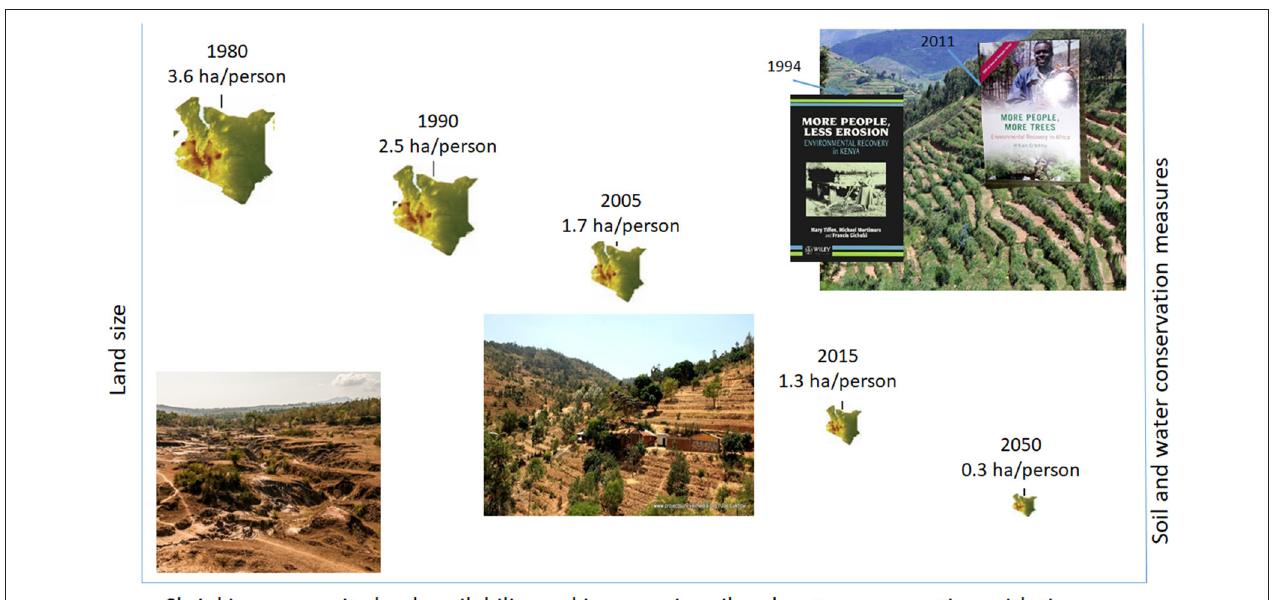
FIGURE 7 | Conserve or not: Sand dams coarse sand restoration dilemma (Tiffen et al., 1994; Critchley,